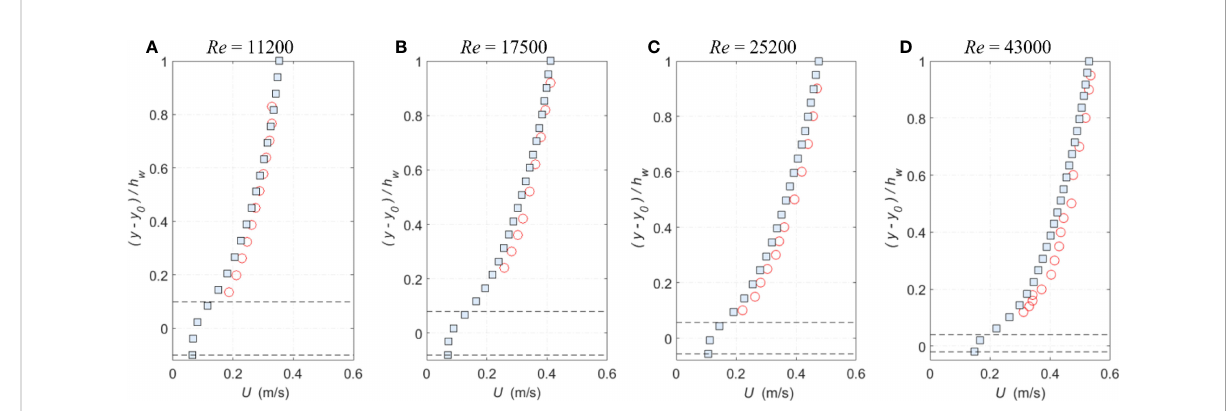
FIGURE 4 (A – D) Comparisons of time-averaged streamwise velocity pro fi les at the fl ume centerline for different fl ow conditions (circles: exp data; squares: smoothed particle hydrodynamics [SPH]; and dash lines: roughness top and bottom).